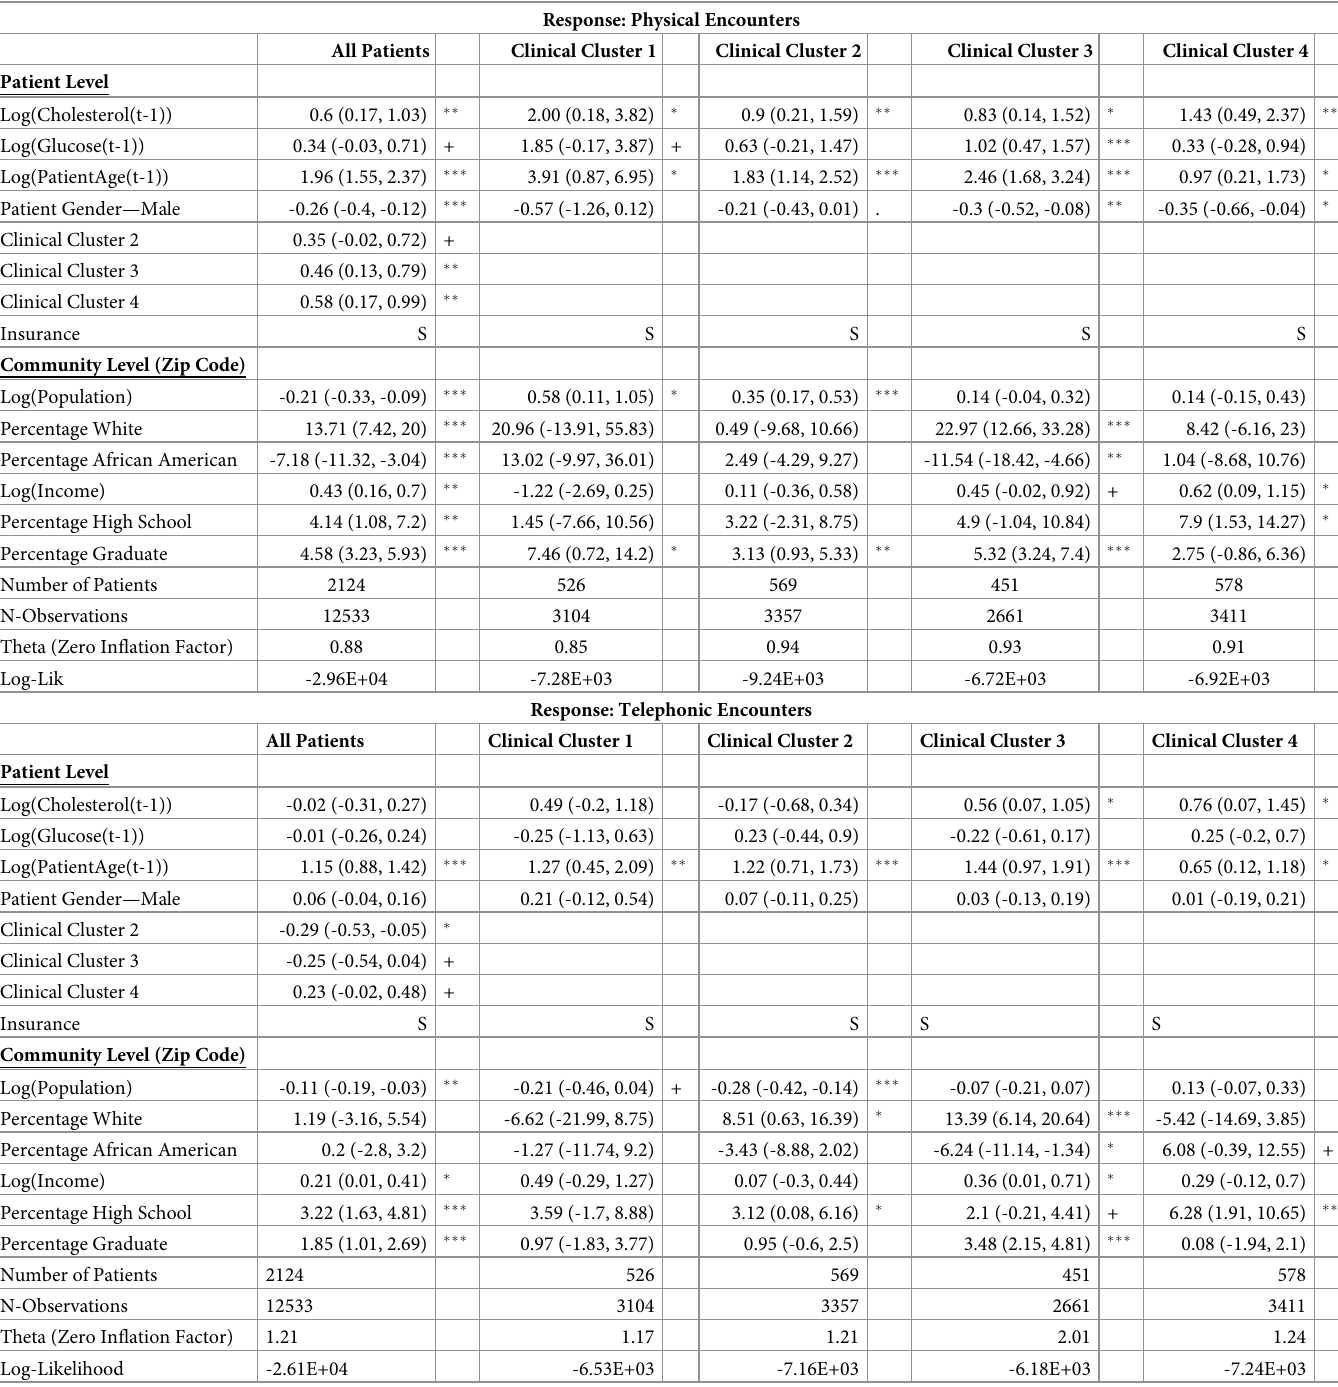
Table 2. Zero-inflated poisson model estimated for physical and telephonic